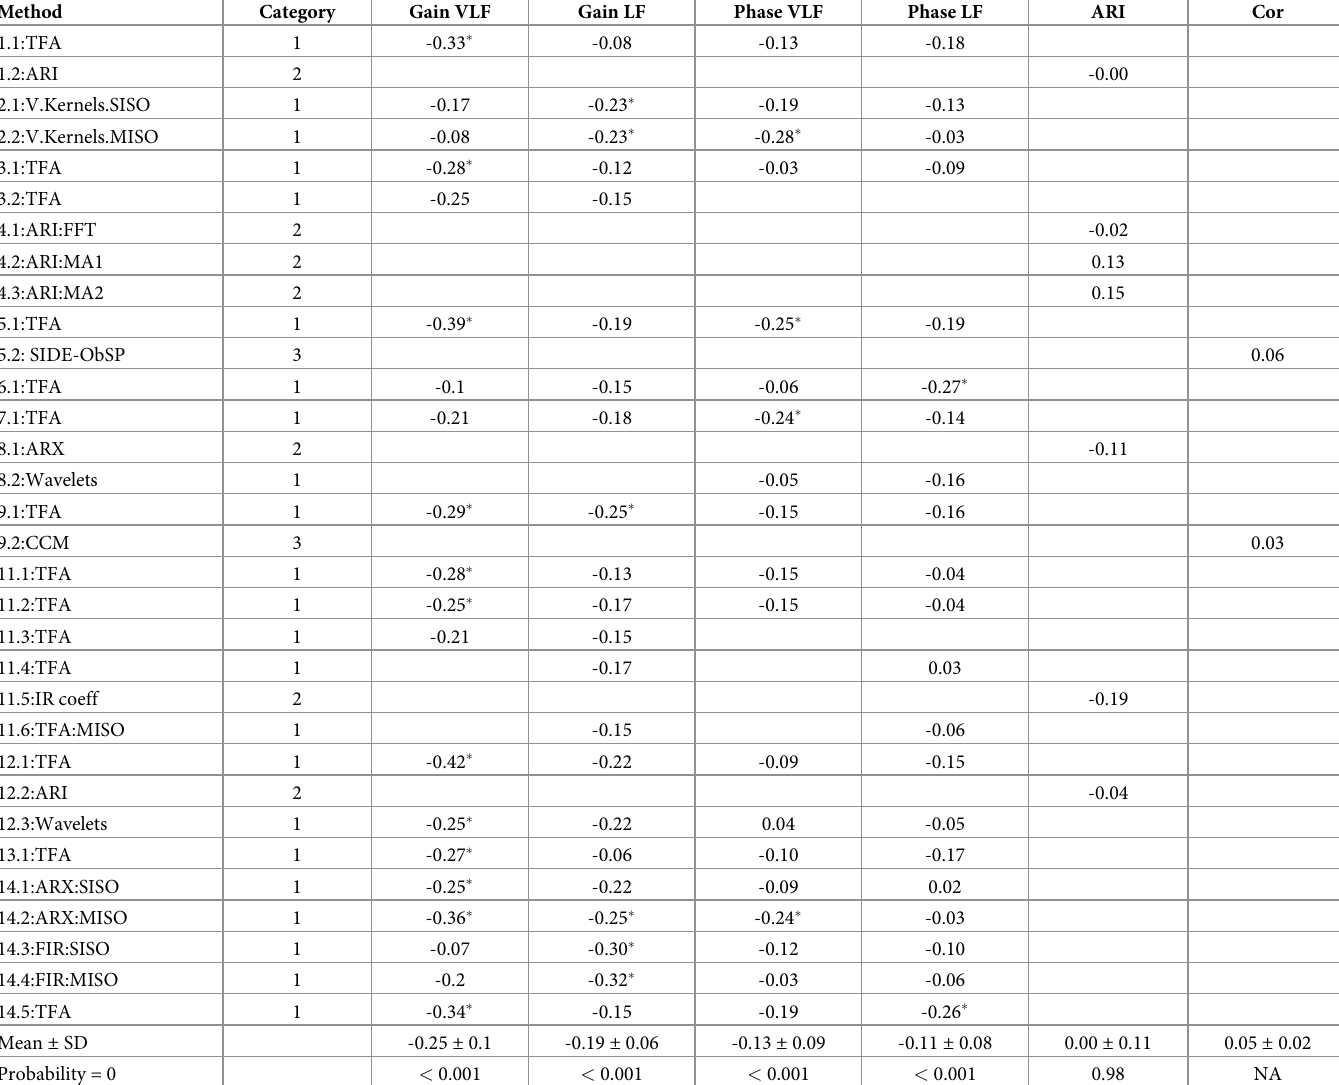
Table 1. Spearman correlation coefficients for the absolute DCA variable difference between the two measurements and the lowest PSD-MABP value of both